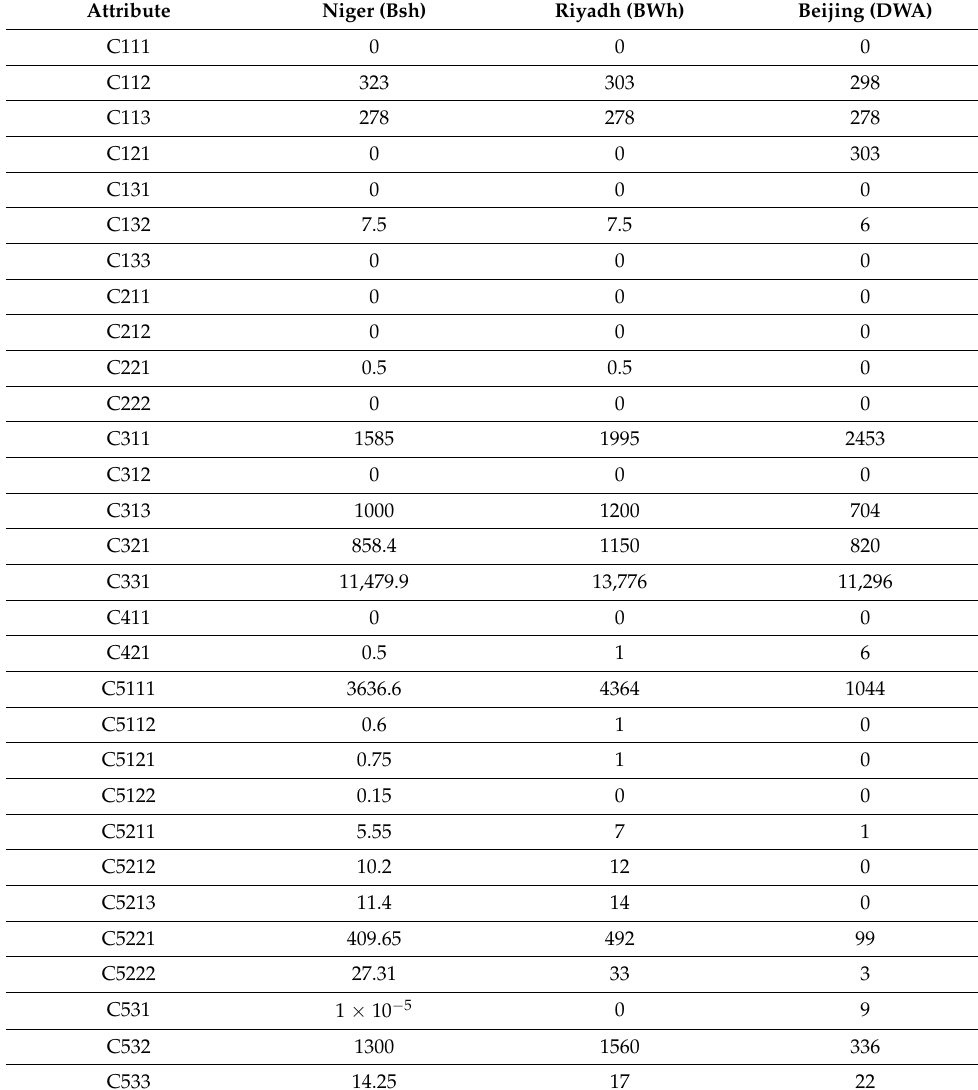
Table 7. Basic attribute values for Niger (Bsh), Riyadh (BWh) and Beijing (DWA) climate zone for VCR